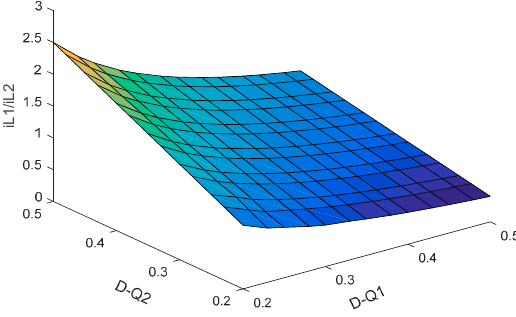
Figure 8. i L 1 / i L 2 3D graph (Charging Mode (Buck)).